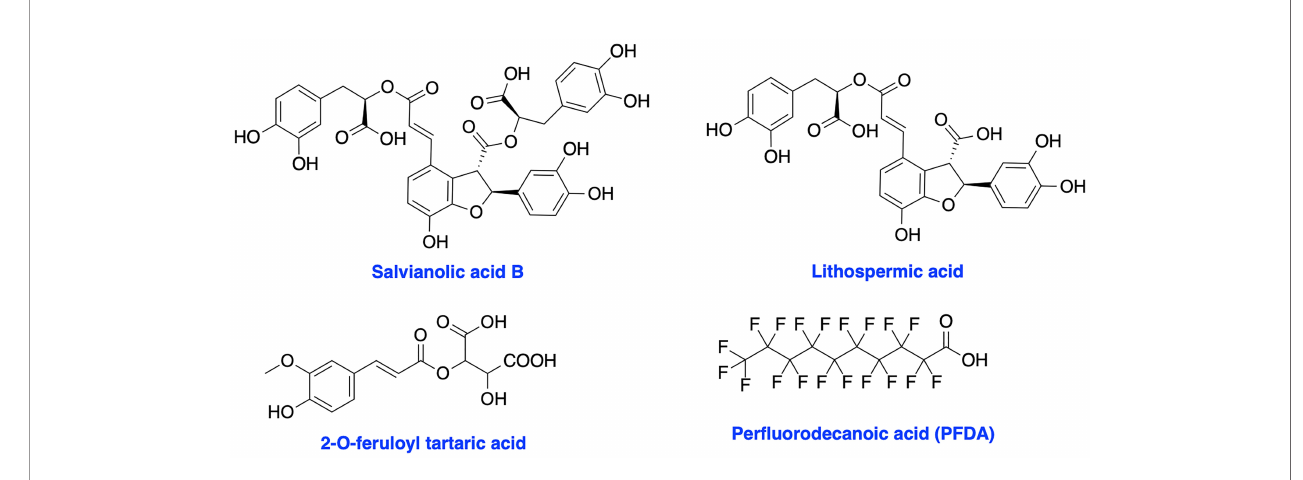
FIGURE 7 | Structures of XRCC4 inhibitors.